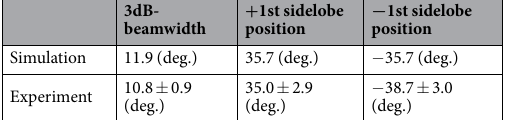
Table 2. Radiation pattern characteristics in the